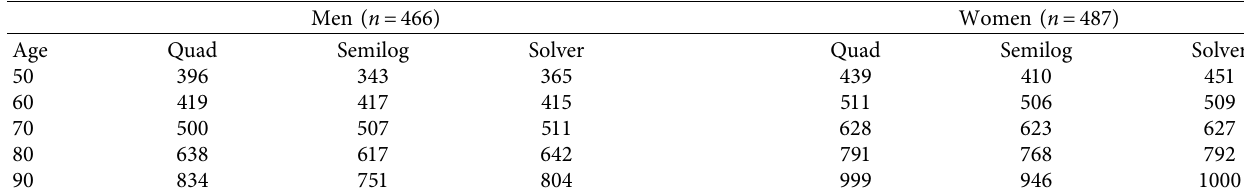
Table 4: Predictions from three